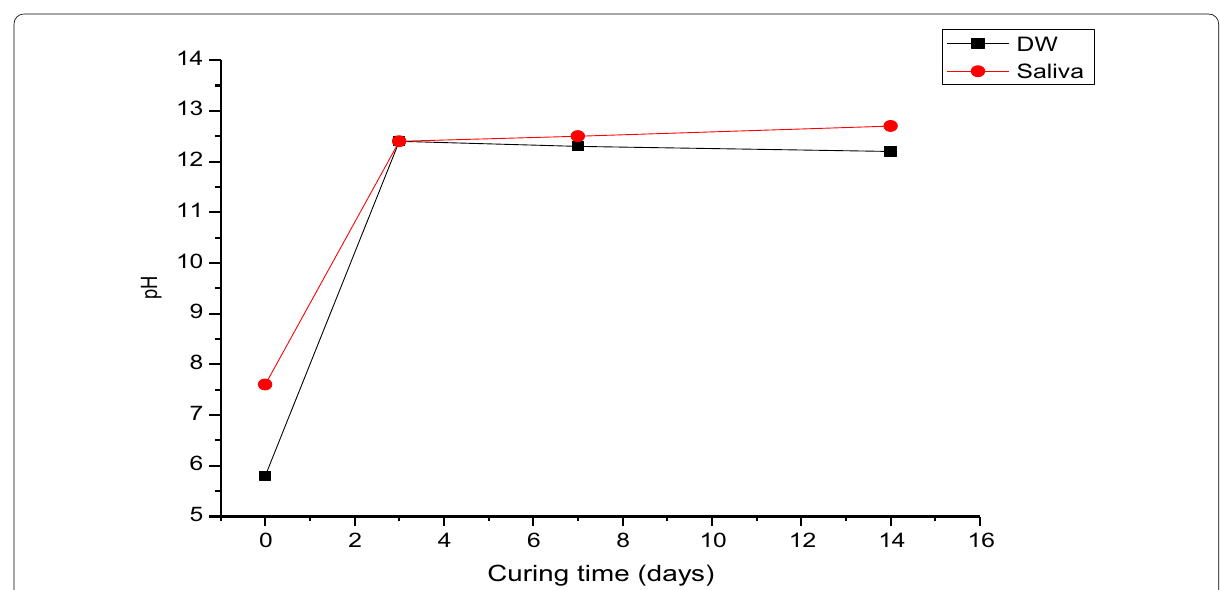
Fig. 8 pH values of the two immersion liquids after zero, 3, 7 and 14 days curing periods